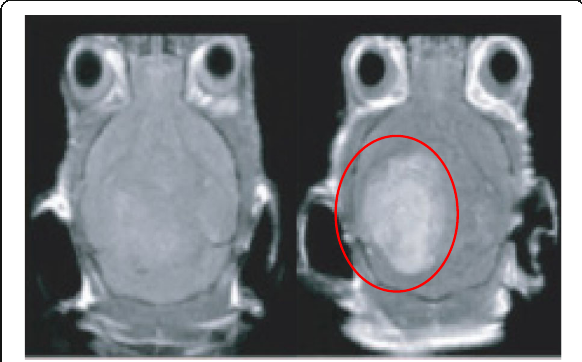
Fig. 5 An MRI contrast image of a rat cerebral cortex pre- (left) and post-treatment (right). The area containing the AuNPs is ringed in